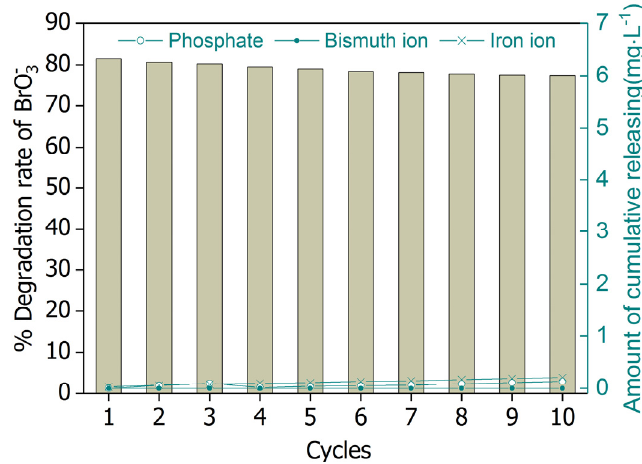
Figure 10. Removal of bromate by UV/BiOCl-HAP SM /formate and element releasing for 10 successive cycles. Conditions: [Formate] 0 = 4 mM; BiOCl-HAP SM dosage 0.5 g · L − 1 , [ BrO (cid:2871)(cid:2879) ] 0 = 6.63 μ M, pH = 7.0 ± 0.1, 25 °C, reaction time 15 min.